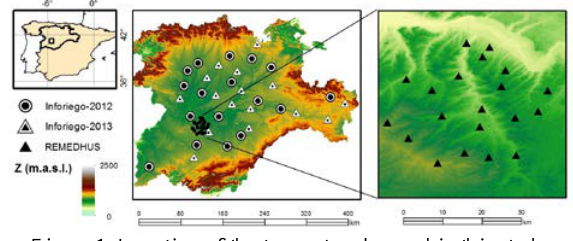
Figure 1. Location of the two networks used in this study.